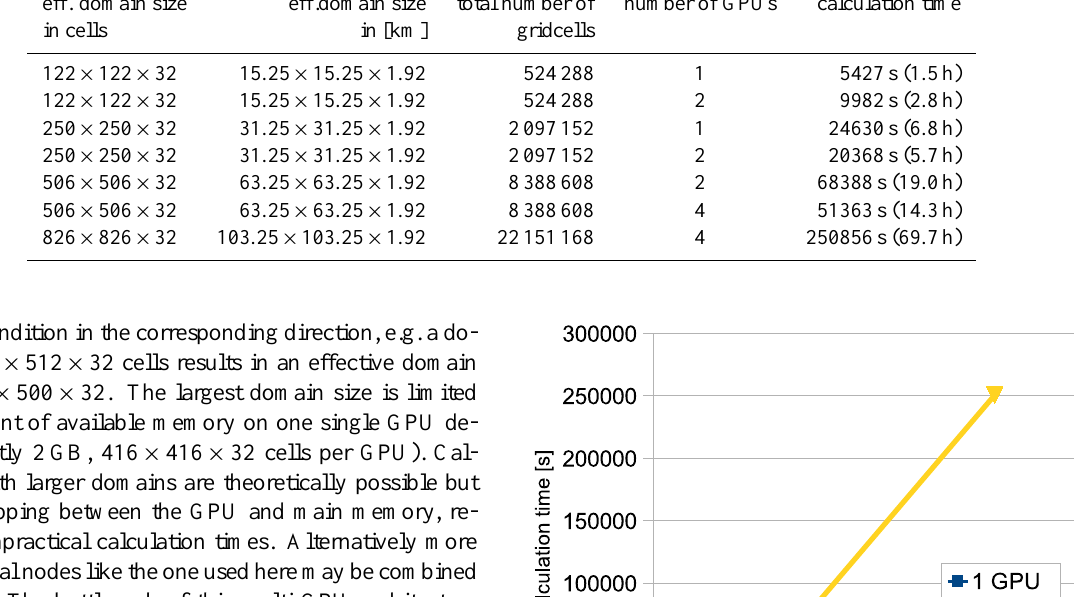
Table 1. Comparison of calculation times depending on domain size and number of used GPUs (AMD Radeon HD 5870) for 16h integration time with 1s timestep at 125m × 125m × 60m resolution for the DYCOMS-II example. eff. domain size